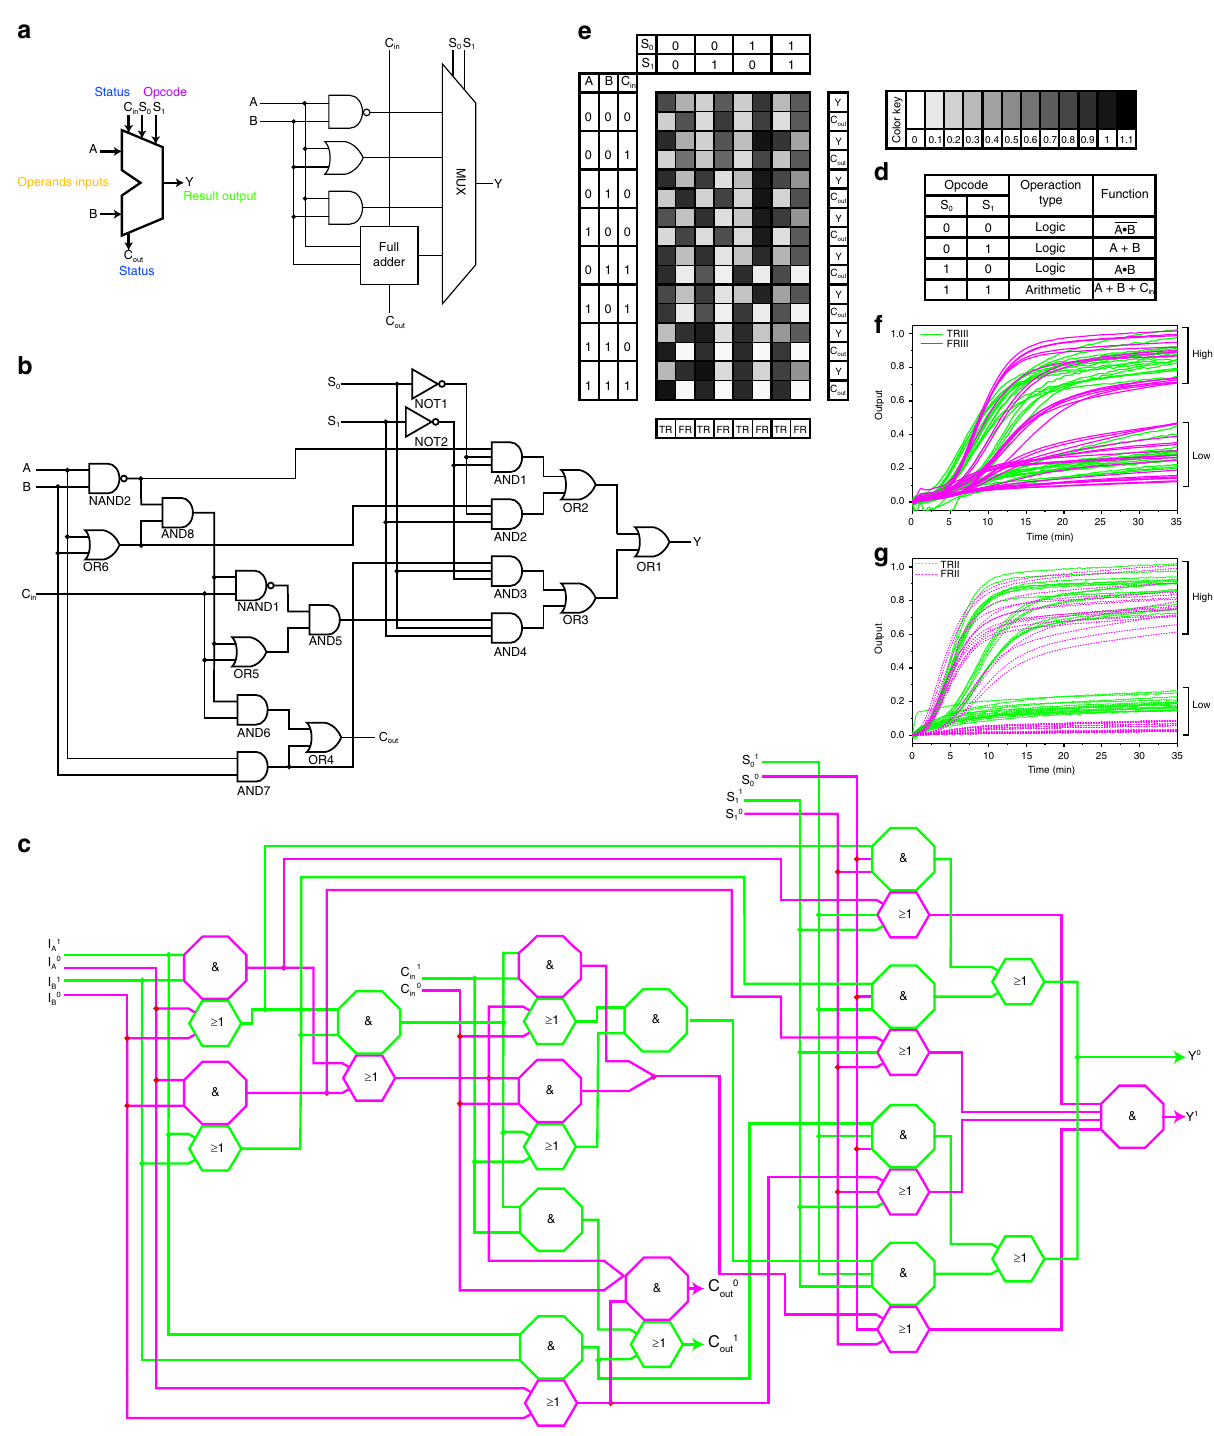
Fig. 4 Construction of DNA ALU with our DNA logic gates. a Abstract diagram of a typical ALU. b A typical construction of a 1-bit ALU with a digital logic circuit. A and B: inputs; C in : carry in; S 0 and S 1 : select signals; Y: output; C out : carry out. c Assembling the 4:1 multiplexer with DNA components. The sequences of the strands are listed in the Supplementary Table 2. The details of the integrated logic gates are shown in Fig. S20. d Function table of the DNA ALU. e Summary of the outputs of the ALU. f , g Reaction kinetics of the ALU with all possible combinations of inputs. The reaction was performed with 12 U Bst polymerase (large fragment), TRIII, FRIII, TRII, and FRII. The curve was plotted by transferring the cycle values into the reaction time. The outputs were normalized to the RFU values in the FAM, ROX, HEX, and Cy5 channels with the highest signals. The TRIII (FAM) and FRIII (ROX) signals correspond to the TRUE and FALSE returns of Y, respectively. The TRII (HEX) and FRII (Cy5) signals correspond to the TRUE and FALSE returns of C out, respectively. The reaction kinetics of the individual gates can be seen in Supplementary Fig. 22. The sequences of the DNA strands are listed in the Supplementary Table